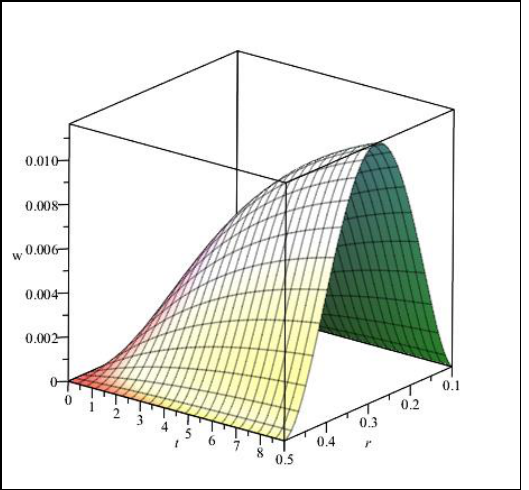
Figure 8. Three-dimensional view of deflection changes versus 𝑟 and time ( 𝑡 ) for 𝑔 = 5 .